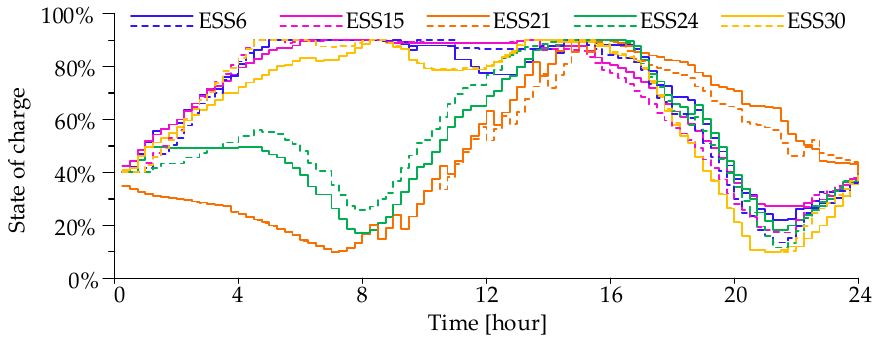
Figure 7. State of charge of ESSs according to day-ahead scheme. Note that the uptrend of the curves indicates charging of ESSs, while the downtrend means discharging.